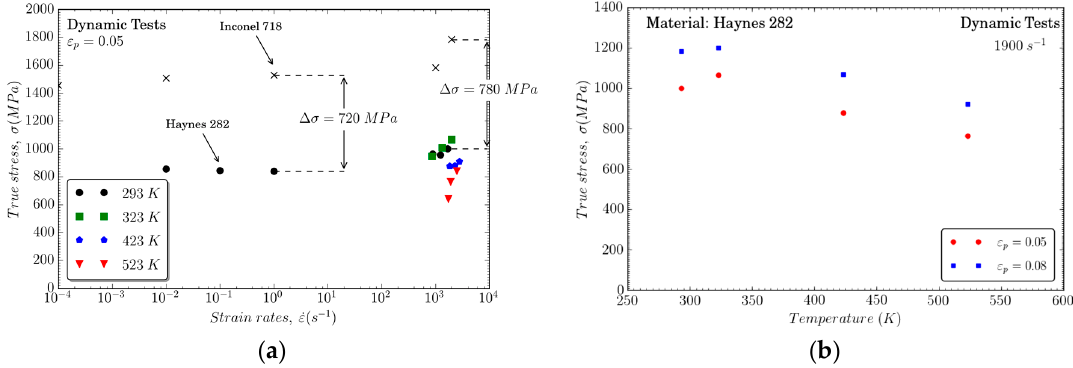
Figure 4. Flow stress evolution versus: ( a ) strain rate and ( b ) temperature for different plastic strain levels.